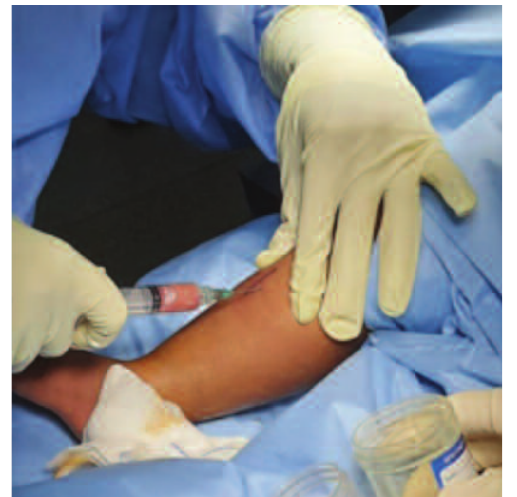
Aspiration of pus from subcutaneous abscess of right Fig. 3: proximal tibia region.